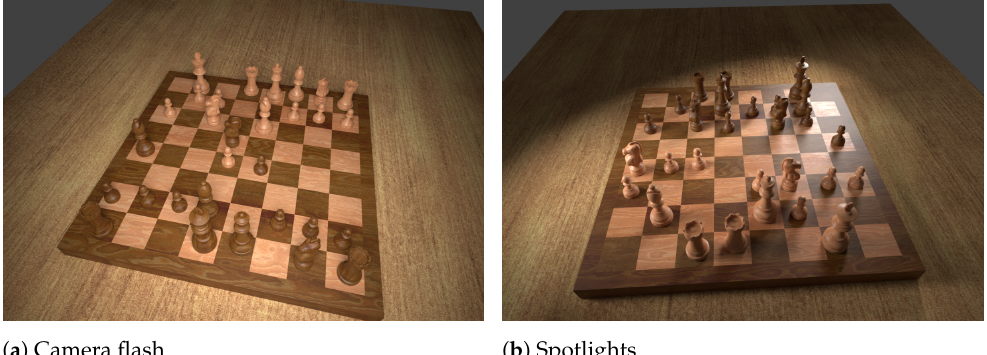
Figure 1. Two samples from the synthesised dataset showing both lighting modes. The dataset contains 104,893 samples of squares occupied by a piece and 207,939 empty squares. In the occupied squares, the most frequent class are black pawns with 27,076 occurrences and the least frequent are black queens with 3133 samples. We make the full dataset publicly available [1] and include additional labels to benefit further research, such as the pieces’ bounding